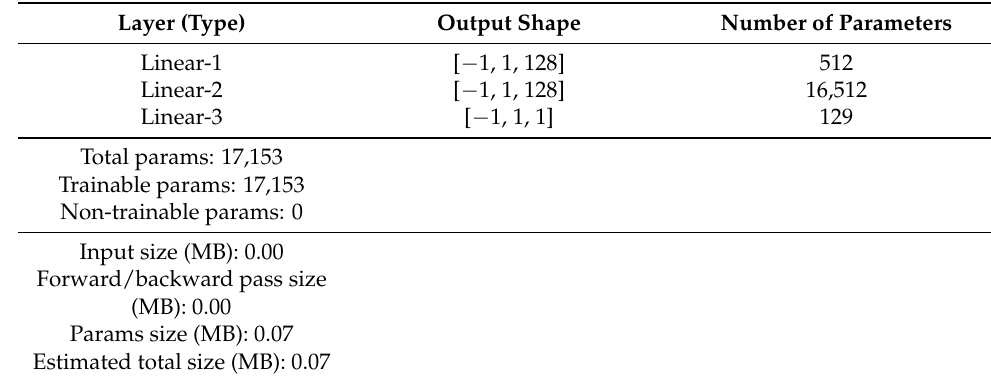
Table 1. The estimation of SIREN network size with two layers.